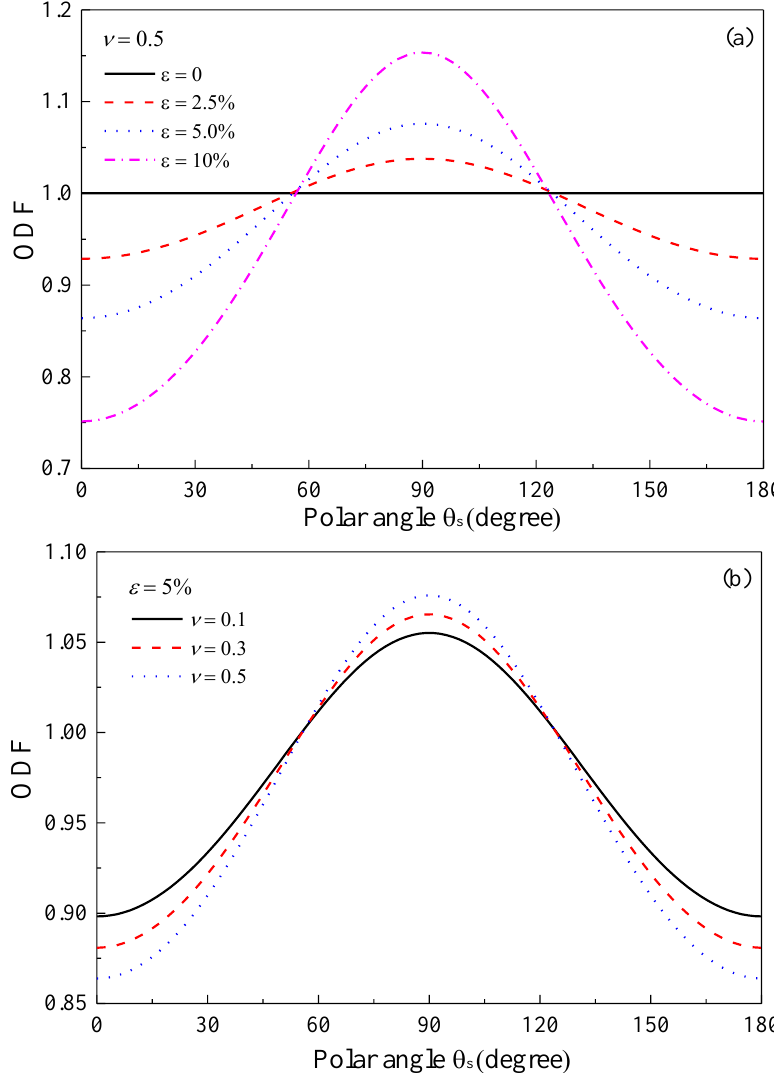
Figure 3. Orientation distribution function (ODF) of GPL ( a ) ε = 5%; ( b ) ν = 0.5.